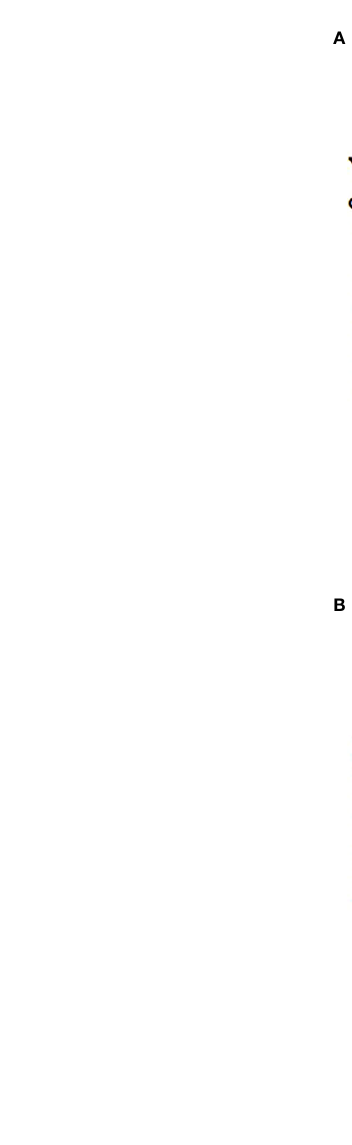
FIGURE 5 The relationship between (A) community respiration (CR) and gross community production (GPP) and (B) net community production (NCP) and GPP in seagrass meadows of Dongsha